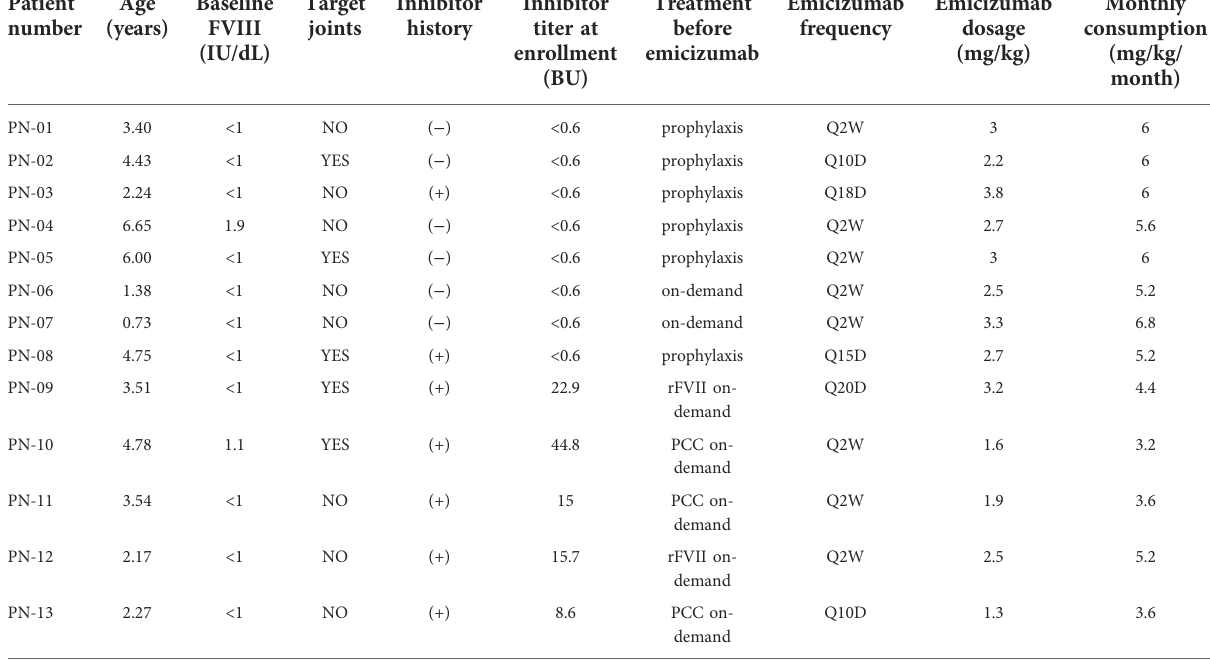
TABLE 1 Patients ’ baseline characteristics and therapy details.